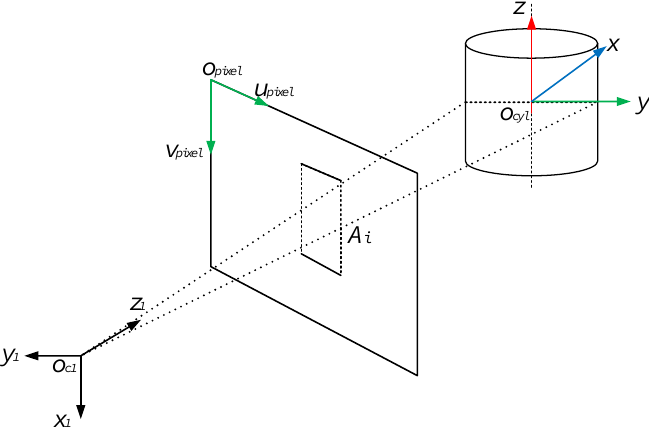
Figure 8. Imaging model of the bottle cap edges.